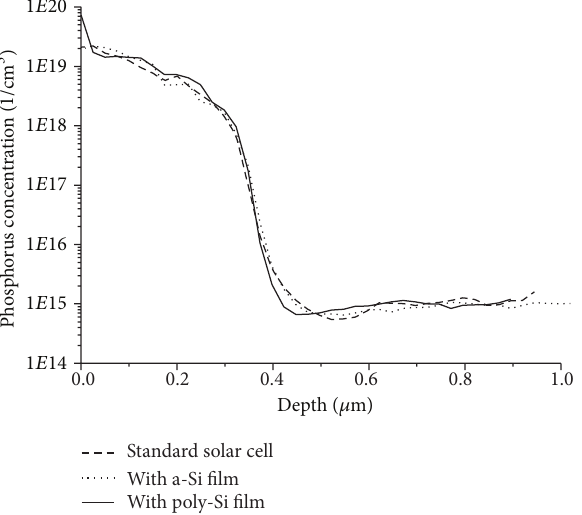
Figure8:Spreadingresistanceprofilesofphosphorusconcentration in the emitter of a standard cell (---), a cell with ∼ 5nm amorphous- silicon film ( ⋅⋅⋅ ), and a cell with ∼ 4 nm poly-silicon film (—).